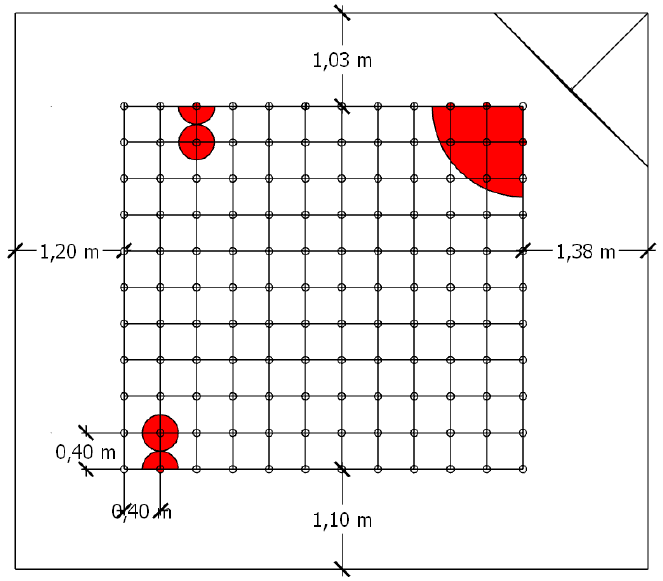
Figure 3. The measurement grid (11 × 12) used for the impulse response measurement. The distance between each microphone position was 0.4 m. 120 points were measured in total. Locations marked in red were removed to avoid getting too close to the sound source or rotating diffuser.